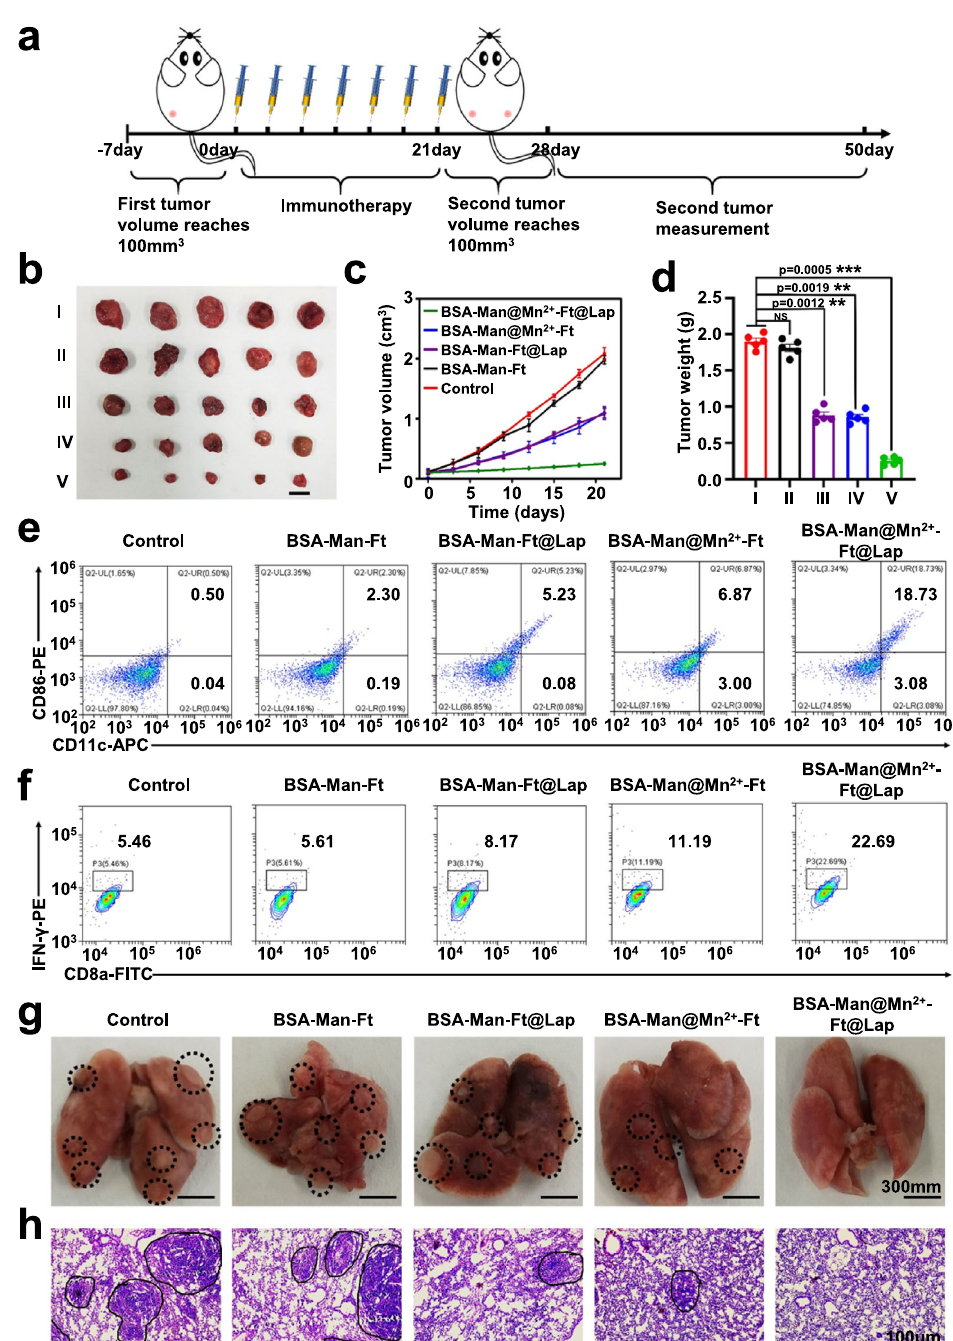
Fig. 9 | BSA-Man@Mn 2+ -Ft@Lap nanoassembly elicits systemic immunity to suppress distal tumors and lung metastasis. a Schematic illustration of the treatment proceduresfor bilateraltumors. b Images of theextracteddistaltumors after various treatments including (I) control, (II) BSA-Man-Ft, (III) BSA-Man- Ft@Lap, (IV)BSA-Man@Mn 2+ -Ft, and(V) BSA-Man@Mn 2+ -Ft@Lap.Scale bar=1cm. c Thechangeinthevolumesofthedistaltumorsthroughoutthetreatmentperiod. (d) The average weight of distal tumors after different treatments. e Expression levels of CD80/CD86 in DCs from lymph nodes of the bilateral 4T1-tumor models after treatment with (I) control, (II) BSA-Man-Ft, (III) BSA-Man-Ft@Lap, (IV) BSA- Man@Mn 2+ -Ft, and (V) BSA-Man@Mn 2+ -Ft@Lap. f Expression levels of CD8a/IFN- γ markers of T cells in distal tumors after treatment with (I) control, (II) BSA-Man-Ft,